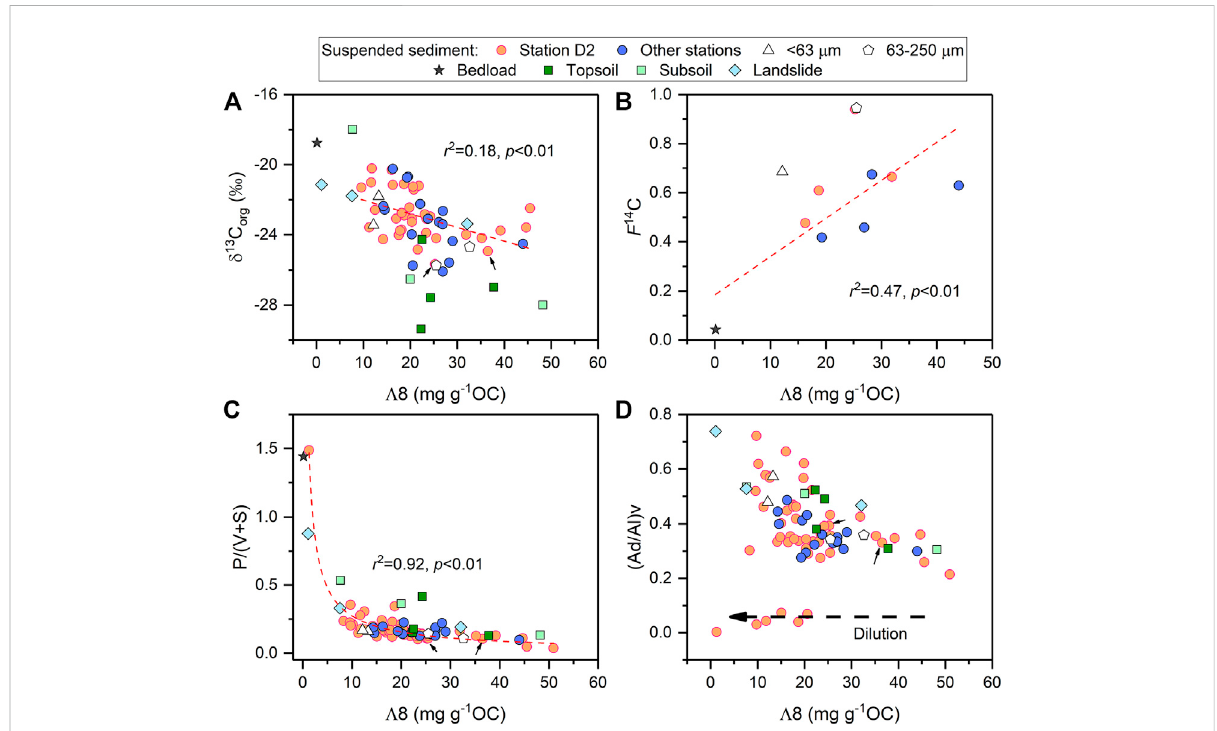
FIGURE 2 Relationships of lignin phenol concentration with organic carbon isotopes (A,B) and lignin degradation proxies (C,D) . P/(V+S) is the ratio of p-hydroxyl (P) phenols to the sum of vanillyl and syringyl phenols. (Ad/Al)v is the ratio of acid-to-aldehyde vanillyl phenols. The arrows indicate the samples in fl uenced by the 2005 debris fl ow event. The dash lines are the linear regression best- fi t to data of suspended sediment in panel A, and of suspended sediment and bed material in panel B. The dash line in panel C is power-law regression best- fi t to the data of suspended sediment. The dash arrow in panel D shows the trend of dilution by clastic